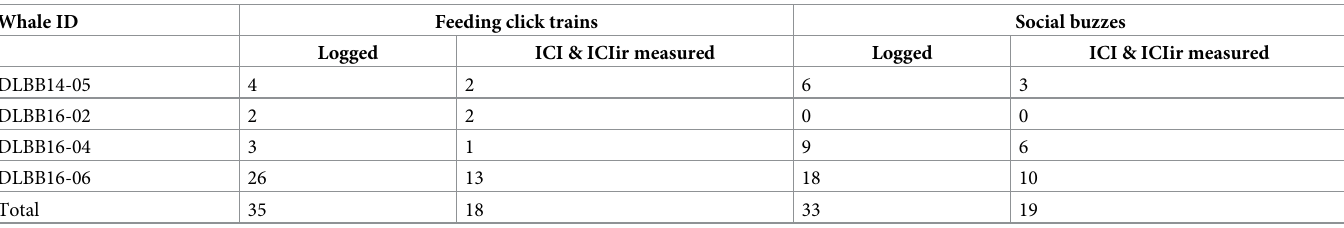
Each row indicates the number of click trains logged during the audit process, and the number of click trains that were successfully processed to obtain ICIs and ICIir during feeding and socializing